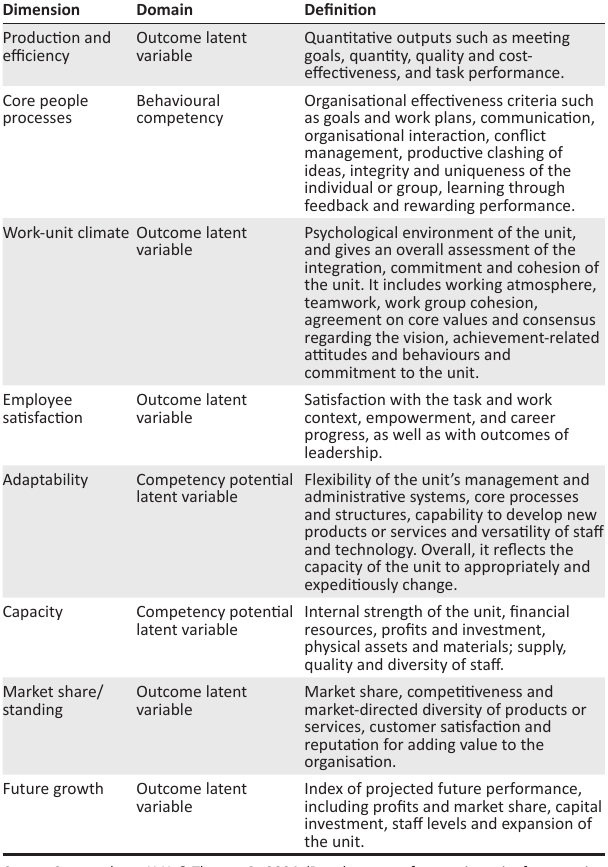
TABLE 1 : The definitions of the Performance Index dimensions and the categorisation of the Performance Index dimensions into